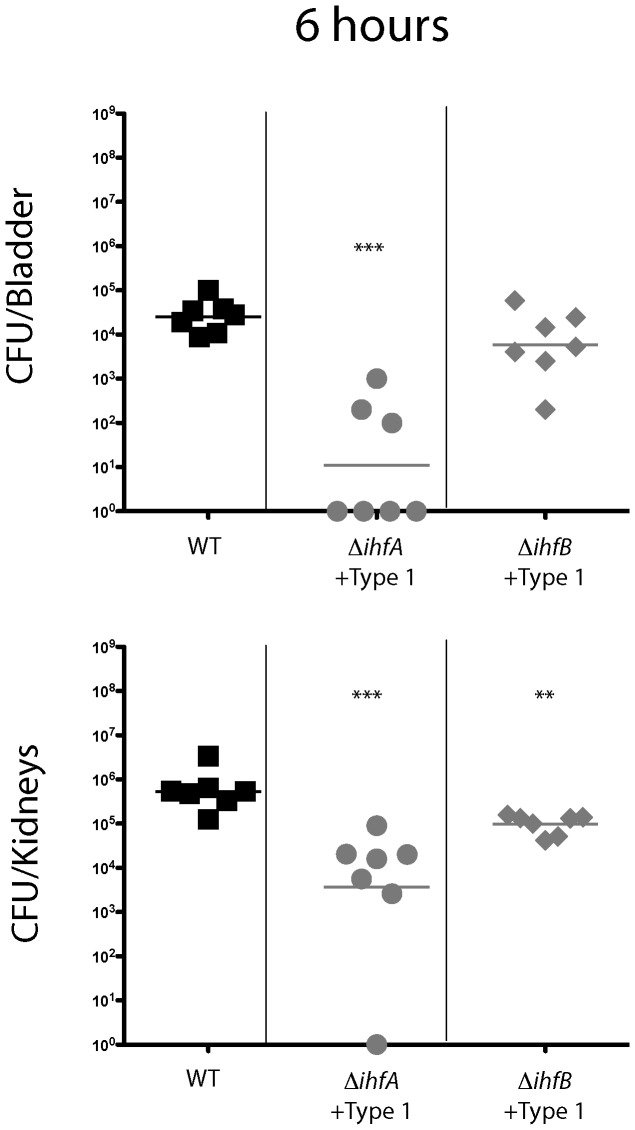
Type 1 piliation does not restore bladder colonization in the absence of IhfA.Each symbol represents single infected murine bladder or combined kidney pair. Female mice were infected with wild type UTI89/pMMB66 (black filled squares), ROL745/pMMB66 (UTI89 ihfA11; gray filled circles), or ROL603/pMMB66 (UTI89 ΔihfB; gray filled triangles) for 6 hours post inoculation. Bacterial burden of bladders and kidneys was enumerated as colony forming units ( CFUs). Statistical significance determined using non-parametric Mann Whitney (**<0.002, *** = 0.0006).